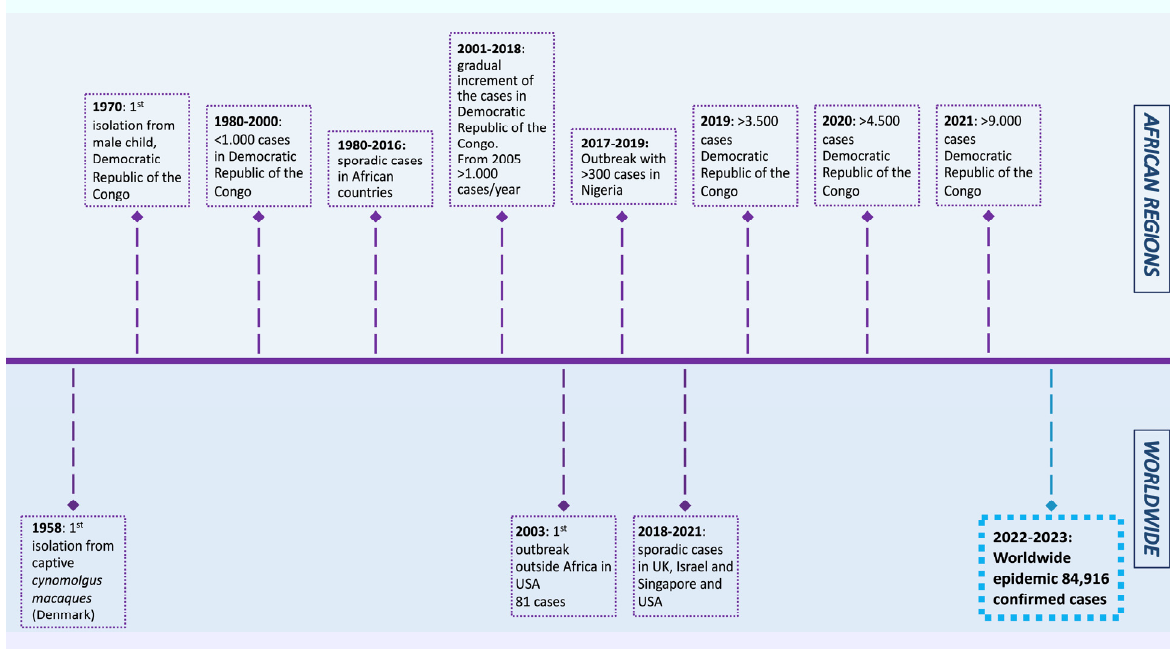
Figure 1. Timeline displaying the history of monkeypox outbreaks (1970–2023)